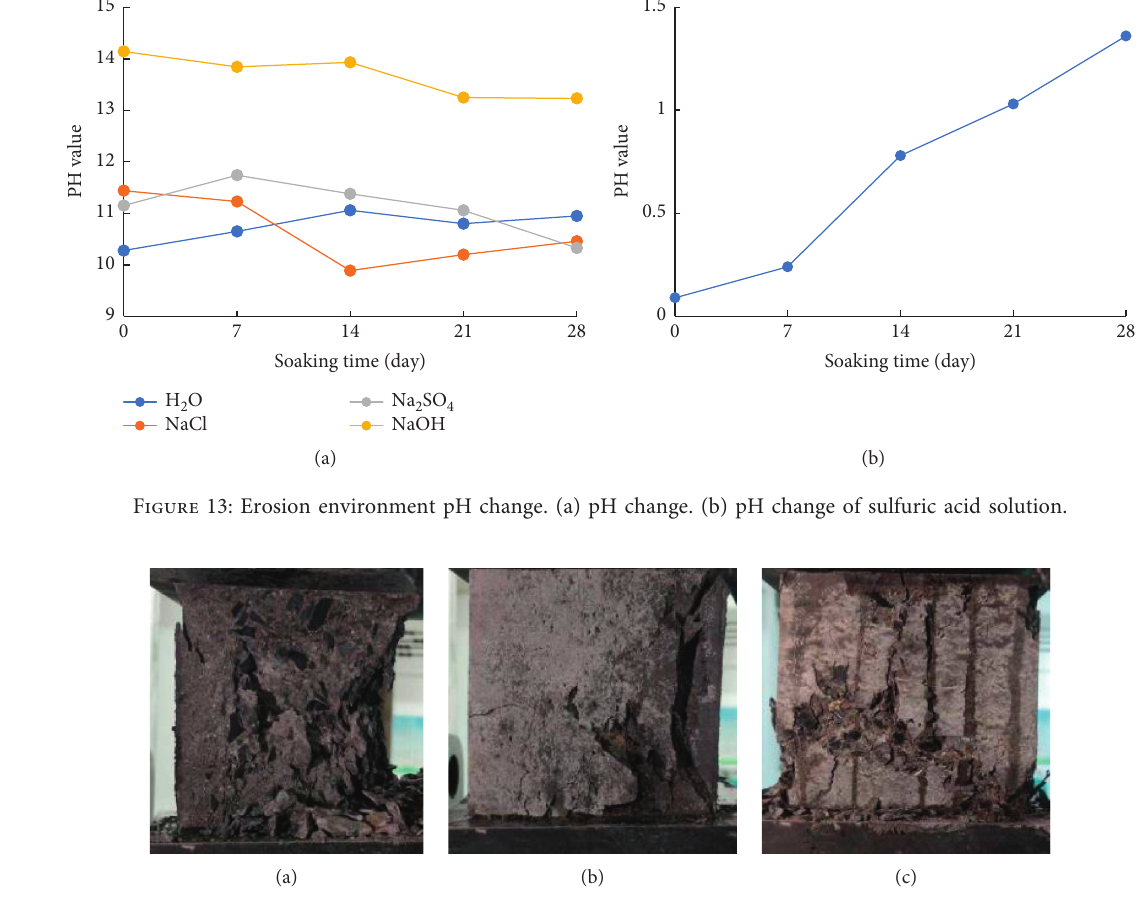
Figure 14: Concrete cubic compressive test. (a) 0%. (b) 1%. (c) 2%. Table 2: Compressive strength of concrete cube.